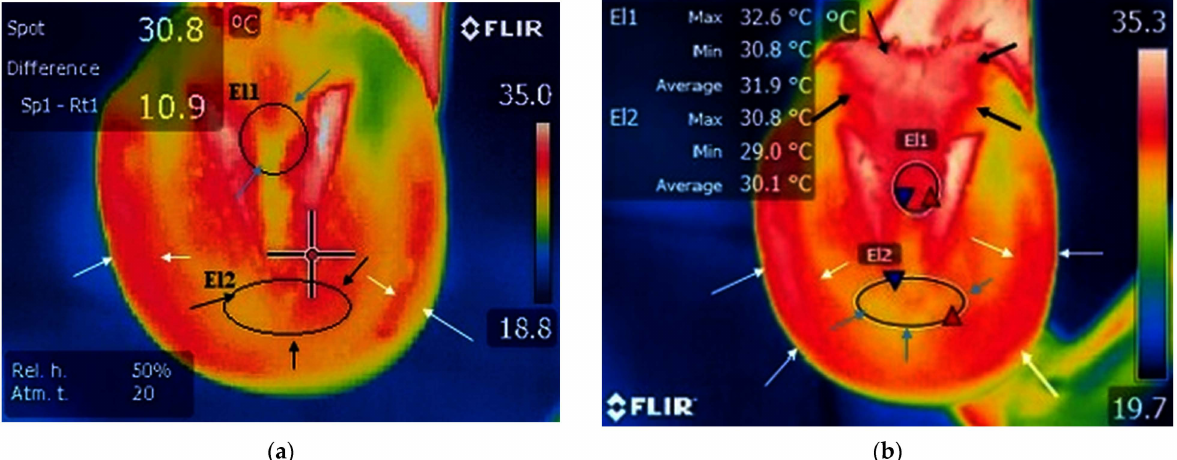
Figure 4. Study group, non-lame limbs: ( a ) sole surface before training—reduced temperature and small surface of temperature in the frog area (blue arrows); increased area of temperature on hoof wall surface (white arrows); reduced temperature in the toe area (black arrows); ( b ) sole surface after training—increased temperature and wider surface of increased temperature in the frog area (black arrows); increased surface of temperature along the hoof wall (white arrows); small surface of reduced temperature in toe area (blue arrows); minimum temperature recorded in the area—blue triangle spot; maximum temperature recorded in the area—red triangle spot.